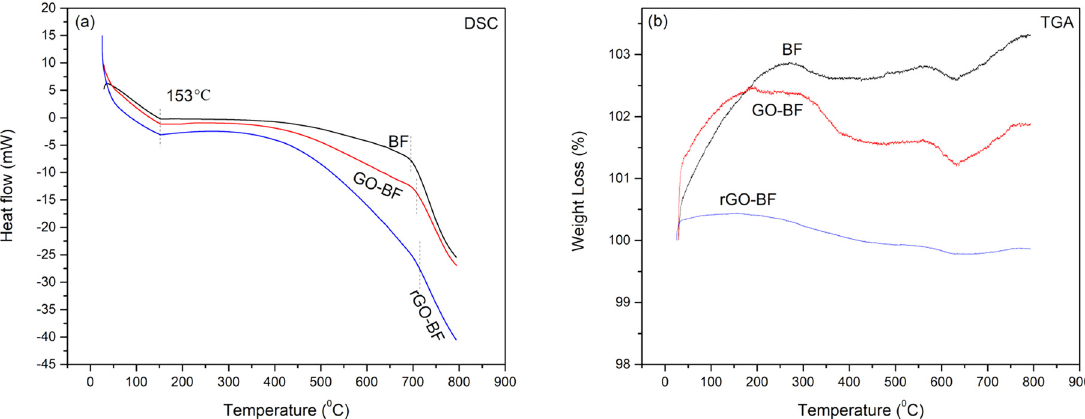
Figure 5: DSC - heating curve ( a ) and TGA ( b ) curves of bare BF, GO - coated BF ( GO - BF ) , and graphene - coated BF ( rGO - BF )